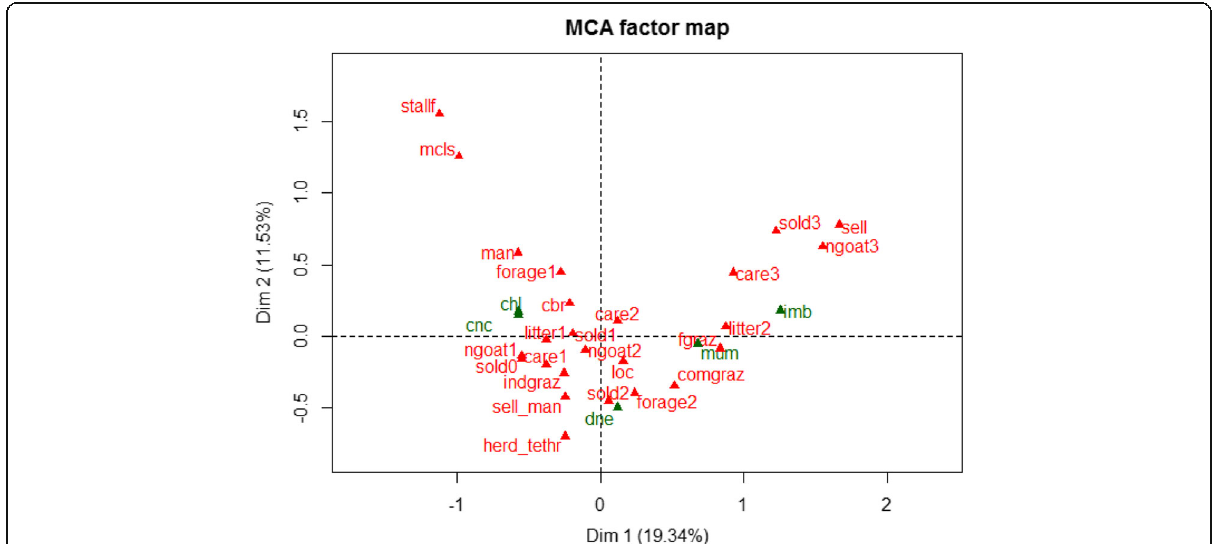
Fig. 2 Result of the multiple correspondence analysis: graphical representation of modalities for the first (Dim1) and second (Dim 2) dimensions. care1, low spending in veterinary care; care2, medium spending in veterinary care; care3, high spending in veterinary care; cbr, mixed flock with indigenous and crossbreds; chl, central highlands; cnc, Congo-Nil-Crest; comgraz, communal grazing; dne, Depressions of the Northeast; fgraz, free grazing; forage1, use of forage crops; forage2, no use of forage crops; herd_teth, herding/tethering; imb, Imbo; indgraz, individual pastures; litter1, presence of litter; litter2, absence of litter; loc, local flock; man, manure; mcls, mixed crop-livestock system; ngoat1, small herds; ngoat2, medium herds; ngoat3, large herds; sell, sale of goats; sell_man, sale of goats and manure; sold0, no sales of goats; sold1, low income from sales; sold2, medium income from sales; sold3, high income from goats sold. Green colour indicates the illustrative variable of agro-climatic